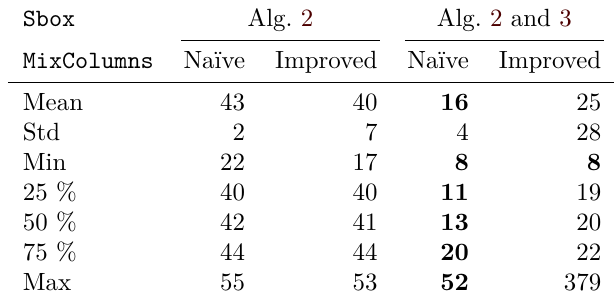
Table 13: Computation time (sec) for 5 rounds of AES on a sample of 4594 dense input/output pairs. Sbox